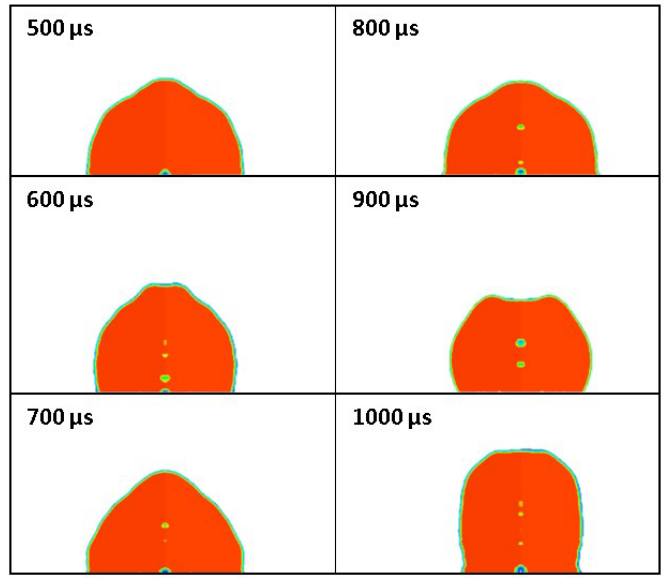
Figure 5. Simulated droplet evaporation shown commencing after impact.